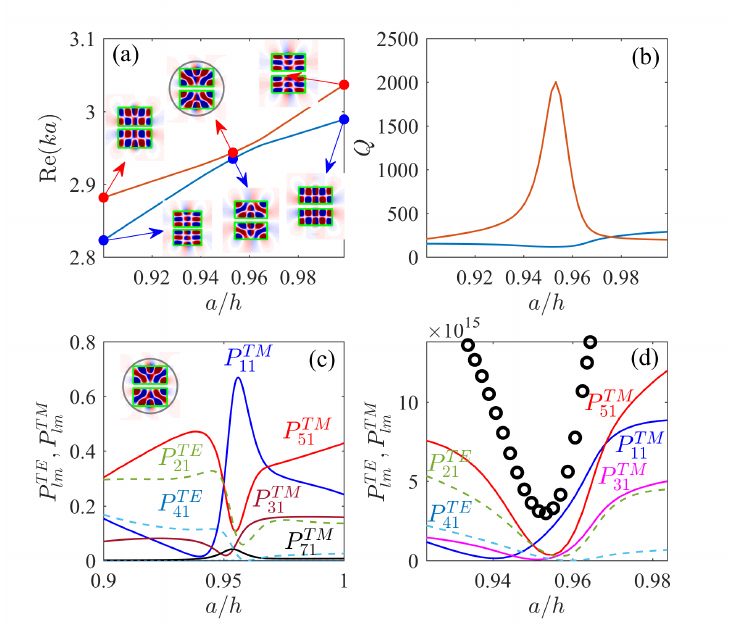
Figure 13. Avoided crossing of two resonances ( a ) and the Q factor ( b ) versus the aspect ratio a / h at L = 1.3 a in the sector m = 1. Evolution of the radiated multipole powers normalized by ( c ) total power and ( d ) by energy inside the